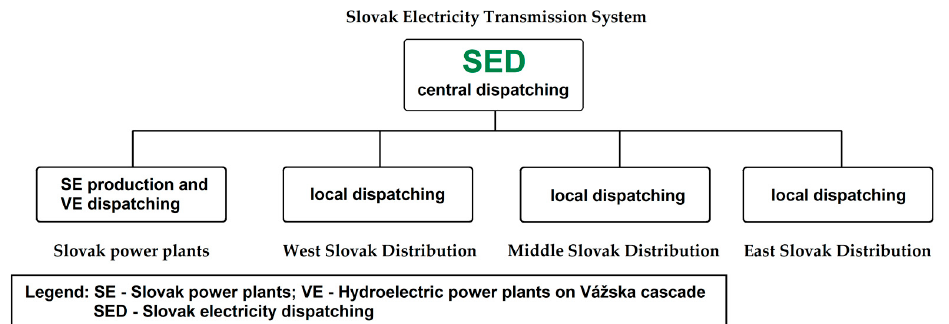
Figure 4. Scheme of distribution of energy system management.